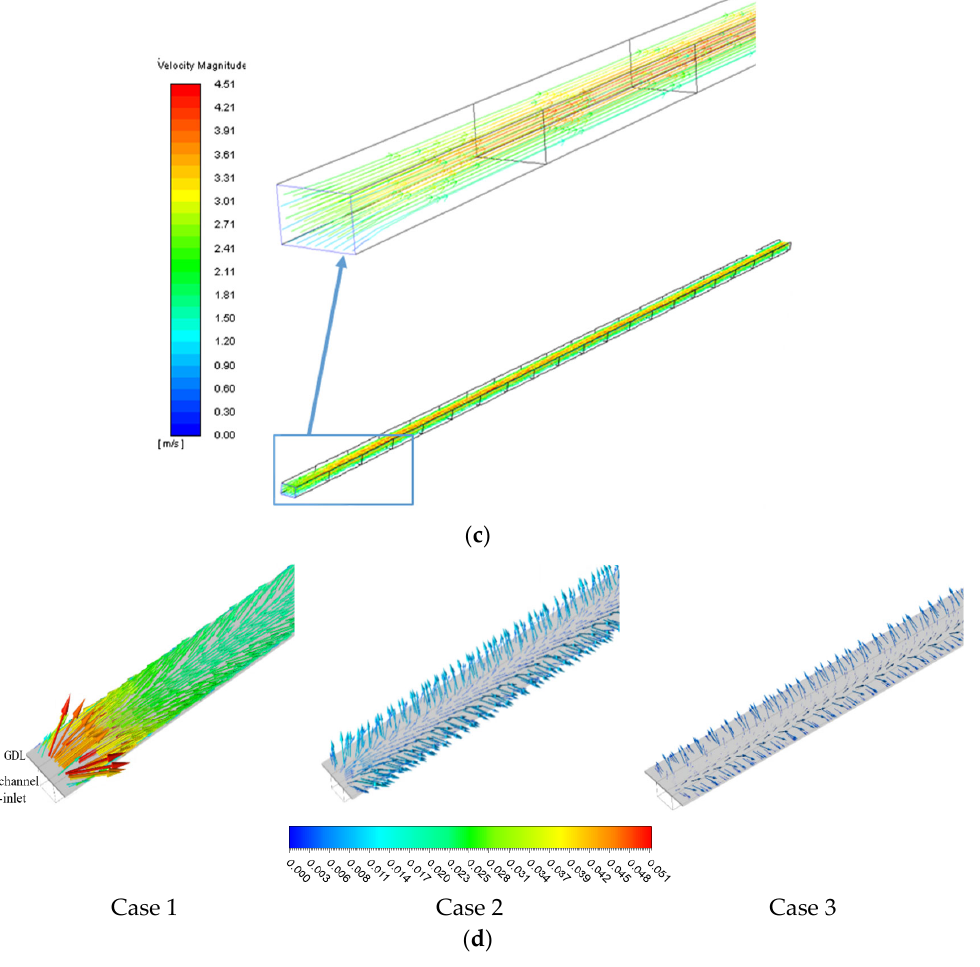
Figure 5. ( a ) Distribution of the oxygen concentration at the 1/2 thickness of cathode GDL, ( b ) dis- tribution of oxygen concentration at the 1/2 thickness of cathode CL, ( c ) streamlines in the cathode channel, ( d ) distribution of gas velocity vector under the channel inlet in the cathode GDL for the three cases.